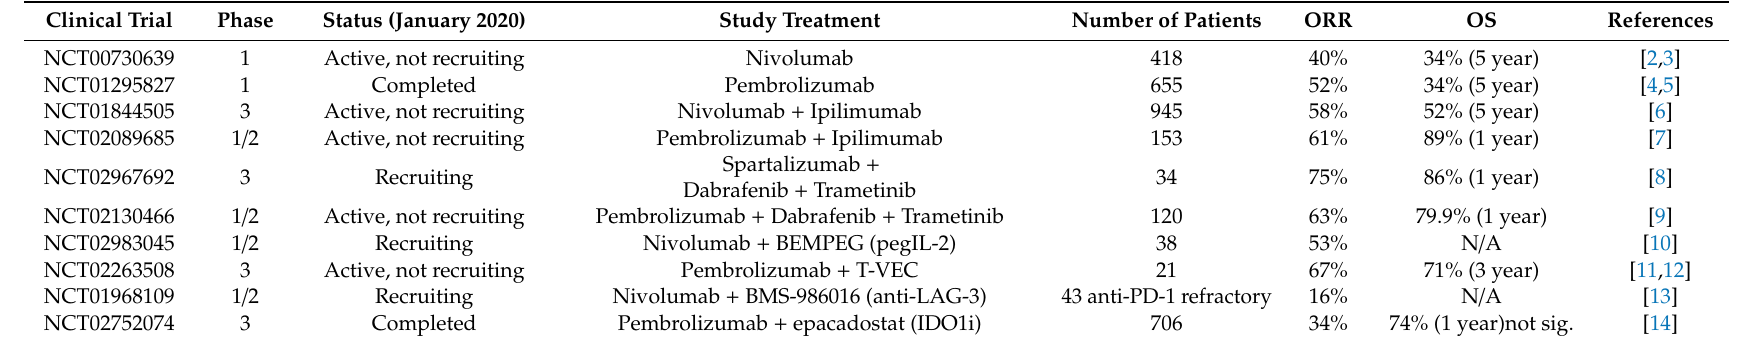
Table 1. Clinical